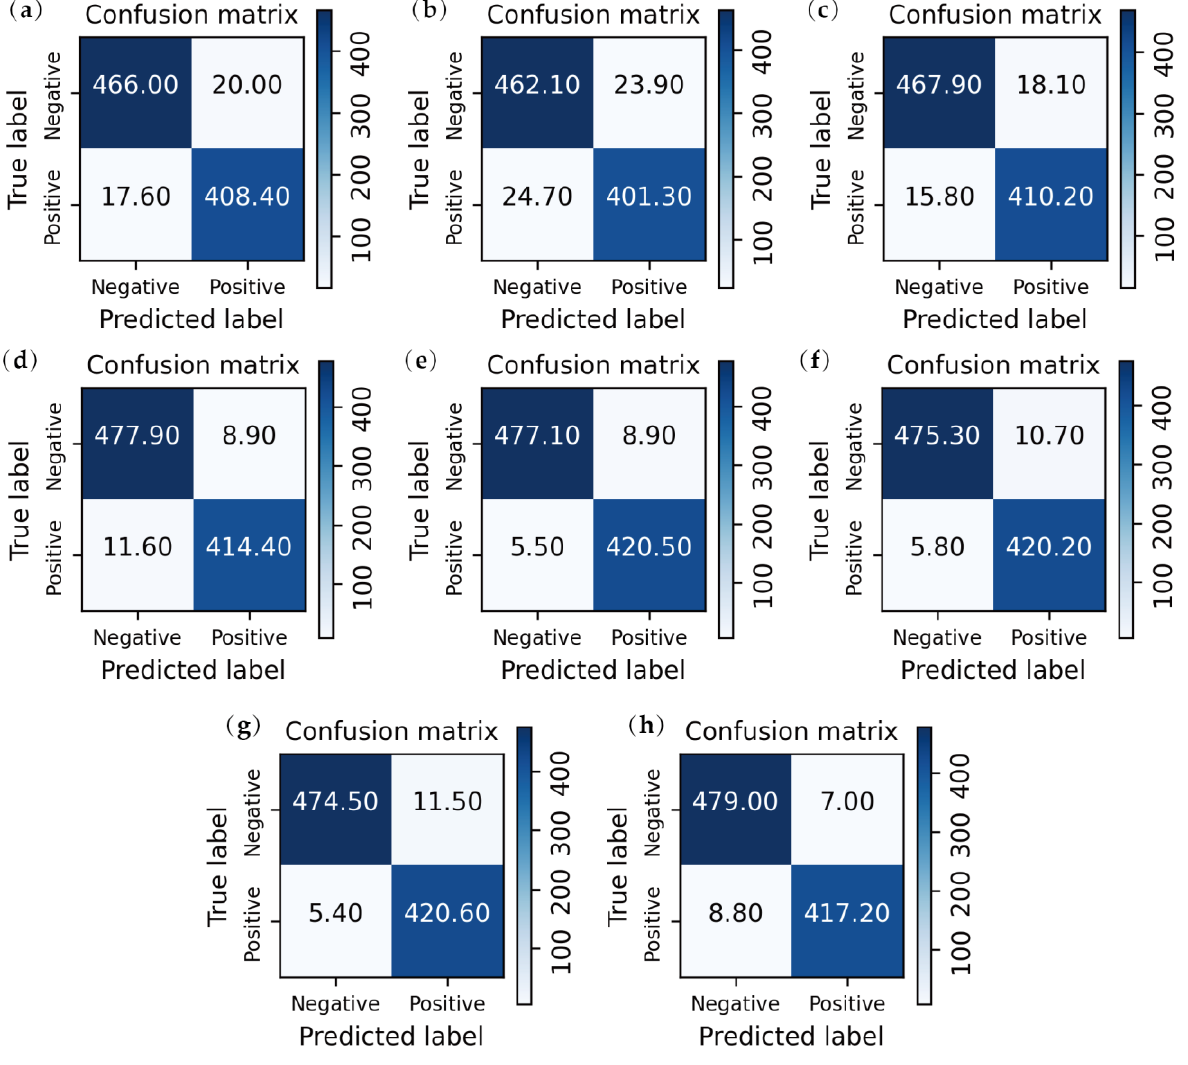
Figure 9. Average confusion matrices for models 1–8 in Table 5. Sub-figures ( a – h ) provide the corresponding visualizations for each model.